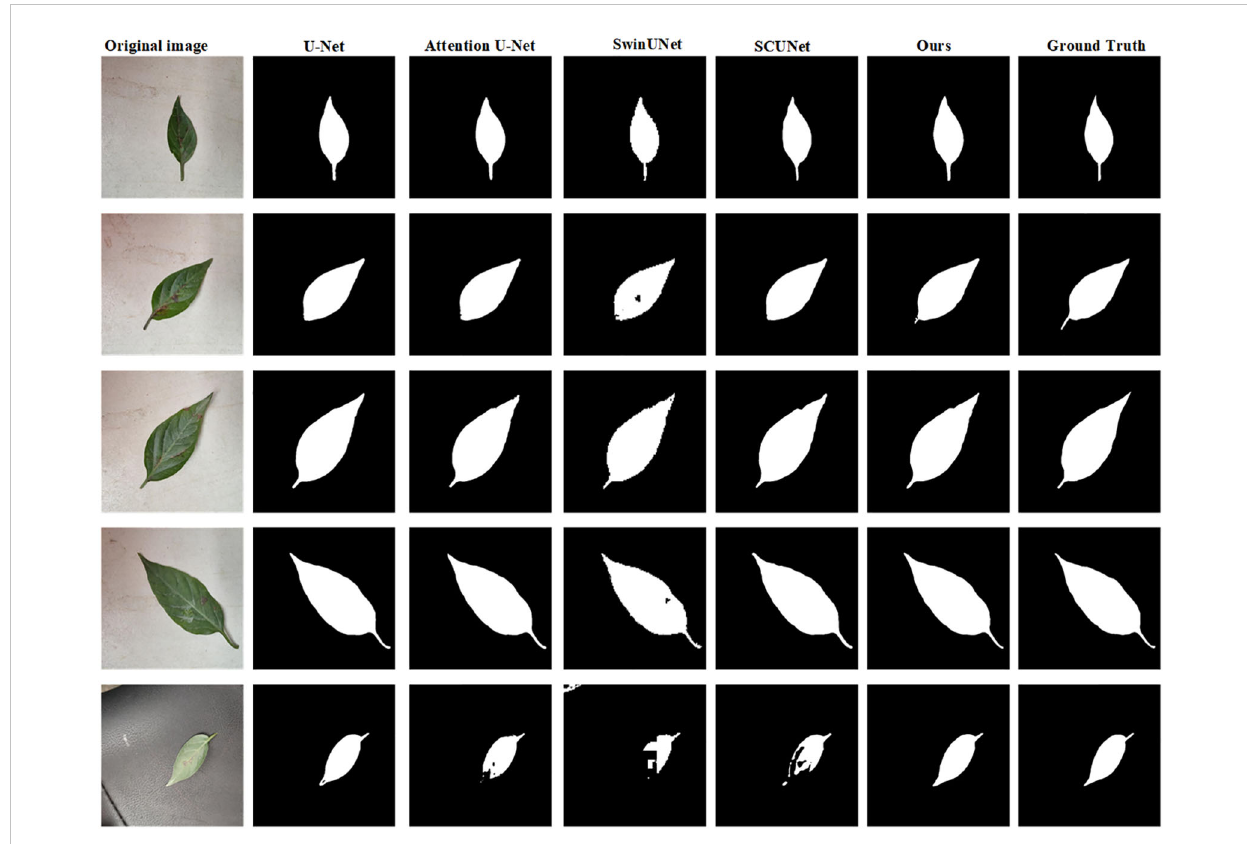
FIGURE 5 Examples of the predicted results using fi ve different models on the SD dataset. From the 1 st column to 7 th column: the original images, the predicted results using the U-Net, attention U-Net, Swin-UNet, SCUNet, the proposed model and ground truth (GT),